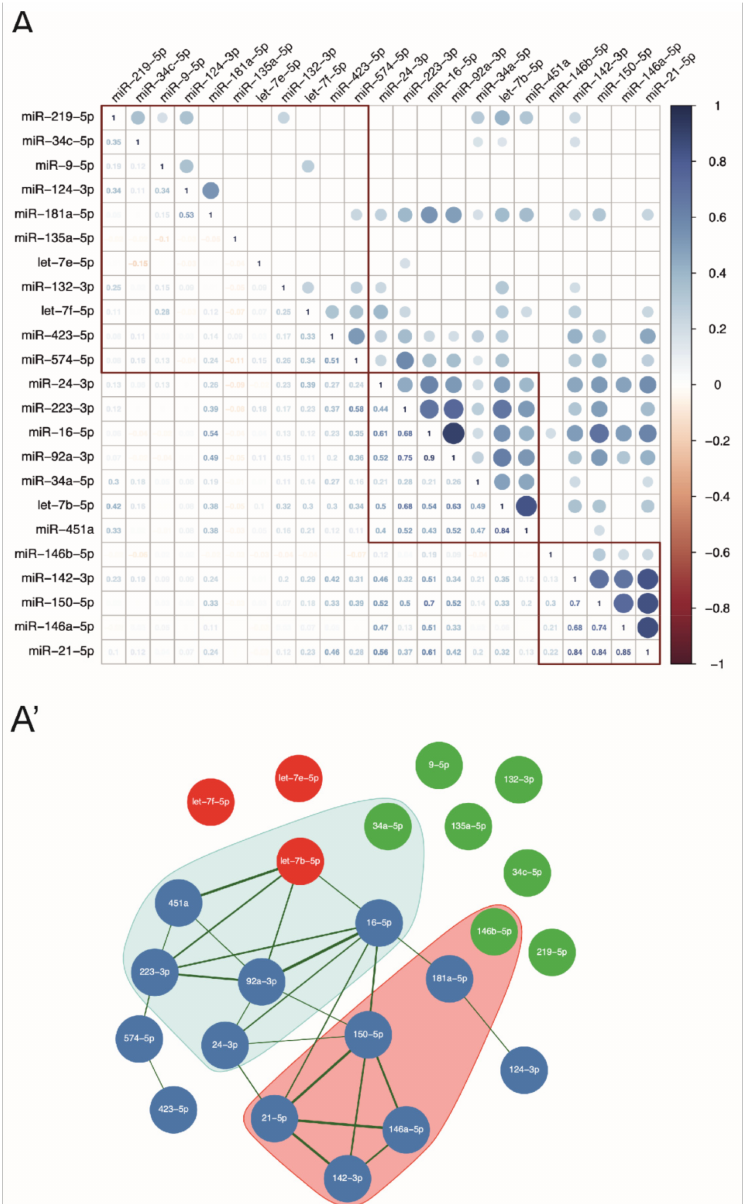
Figure 2. Let-7b-5p is a hub in the network of miRNAs in the CSF of patients with MS. ( A ) Heat map of Pearson’s correlation coefficients (r) between 23 miRNAs (relative to miR-204-5p, according to the ∆ Ct calculation) detected by qPCR in the CSF of the main cohort of patients (n = 166) at T0. In the upper triangle, r values of significant correlation ( p < 0.05) were represented by coloured circles according to the scale (r > 0 is positive correlation, 0 no correlation and < − 1 is negative correlation). In the lower triangle, r values are reported following the color code. Squares represent three different clusters identified by hierarchical clustering using the cutree R function with k = 3. Only statistically significant correlations with FDR < 0.05 are shown. ( A’ ) Network representation of miRNA correlation. In red, there are detected members of the let-7 family (let-7b-5p, let-7e-5p and let-7f-5p). Blue nodes are other miRNAs relevant for MS, which correlate each other and/or with let-7b-5p (r ≥ 0.5). In green are miRNAs with r < 0.5. Pink and light blue areas represent, respectively, the first and the second correlation clusters, highlighted in panel A of the figure by the two lower